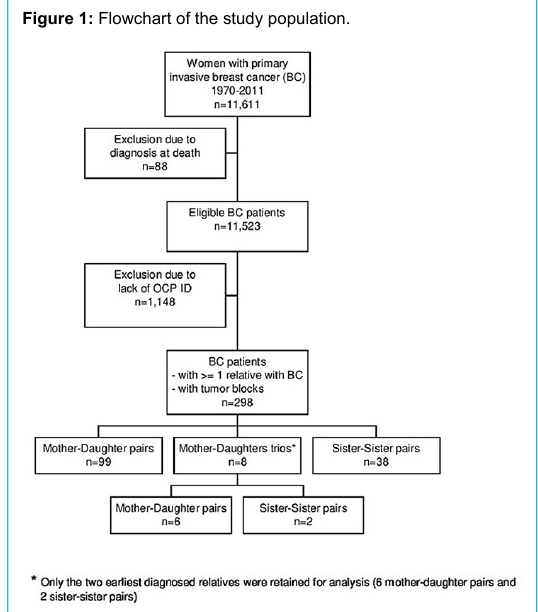
Figure 1: Flowchart of the study